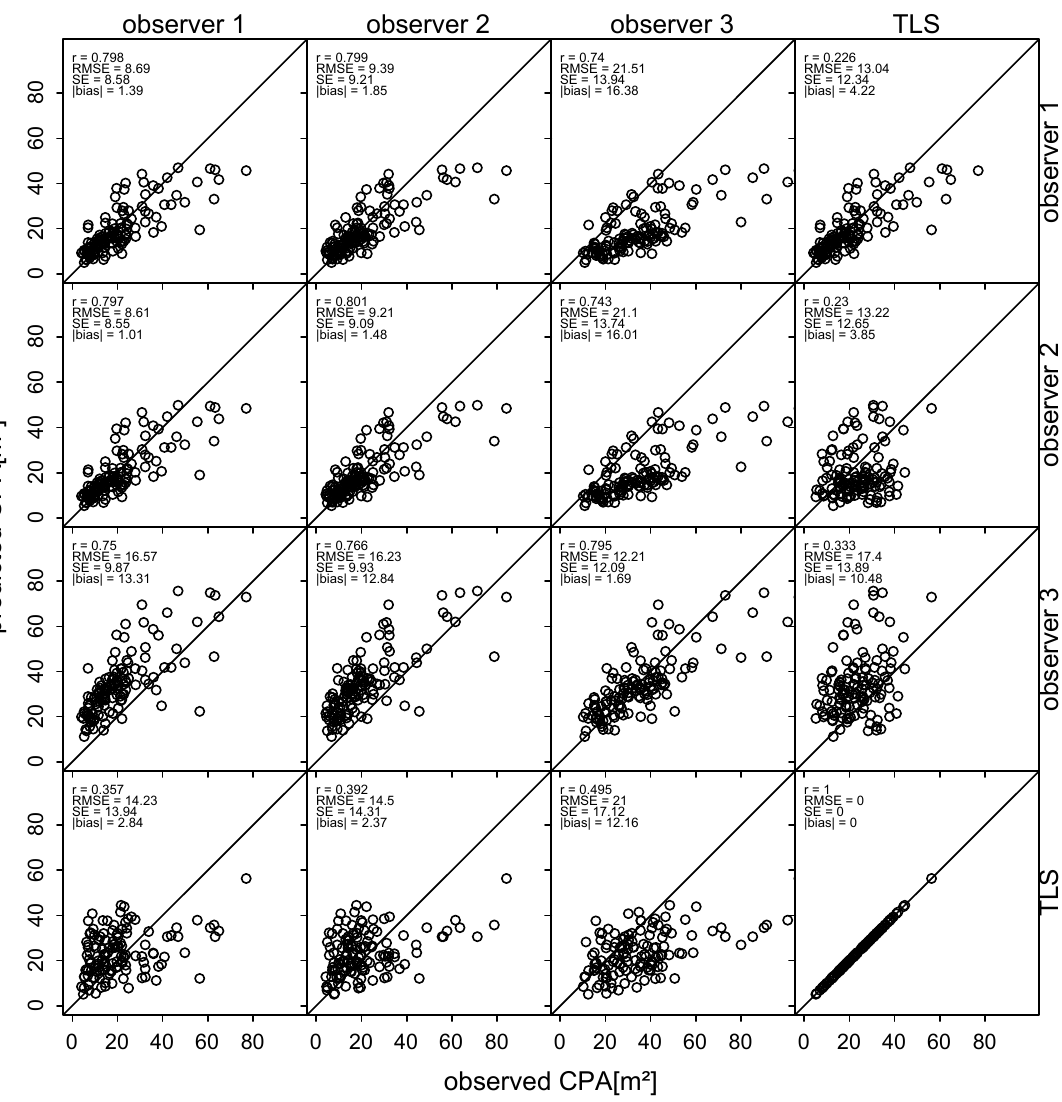
Figure 4. Observed CPA vs. CPA predicted by allometric models that were fitted to the field data obtained independently by the three different observers and terrestrial laser scanning (TLS) CPA estimates for n = 132 trees. RMSE, SE, and |bias| are estimates given in m 2 . r = Pearson’s correlation coefficient. Table 3. Total CPA, total overshadowed area, total gap area, and fractional crown cover estimated from the terrestrial laser scanning (TLS) data and from the allometric models fitted to the field data of three independent observers ( n = 1789 trees; stand area = 4.08 ha). Total CPA (m 2 ) Crown Coverage (m²) Total Gap Area (m²) Crown Coverage (%)